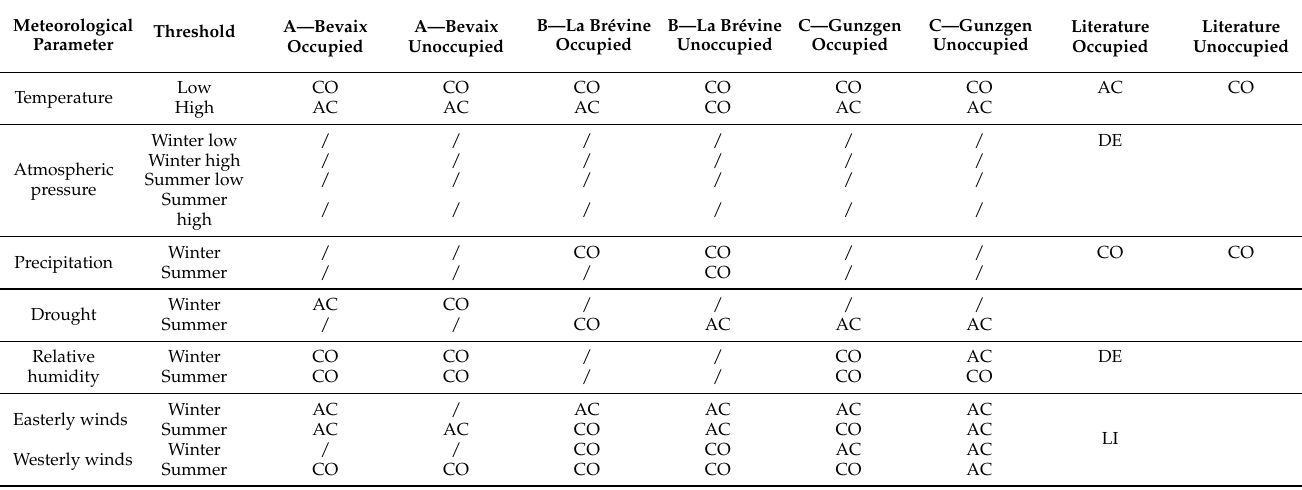
Table 8. Syntheses of meteorological parameter influences on IRC highlighted in this study. AC— anti-correlation; CO—correlation; DE—depends on source; LI—link between parameters; /—no clear